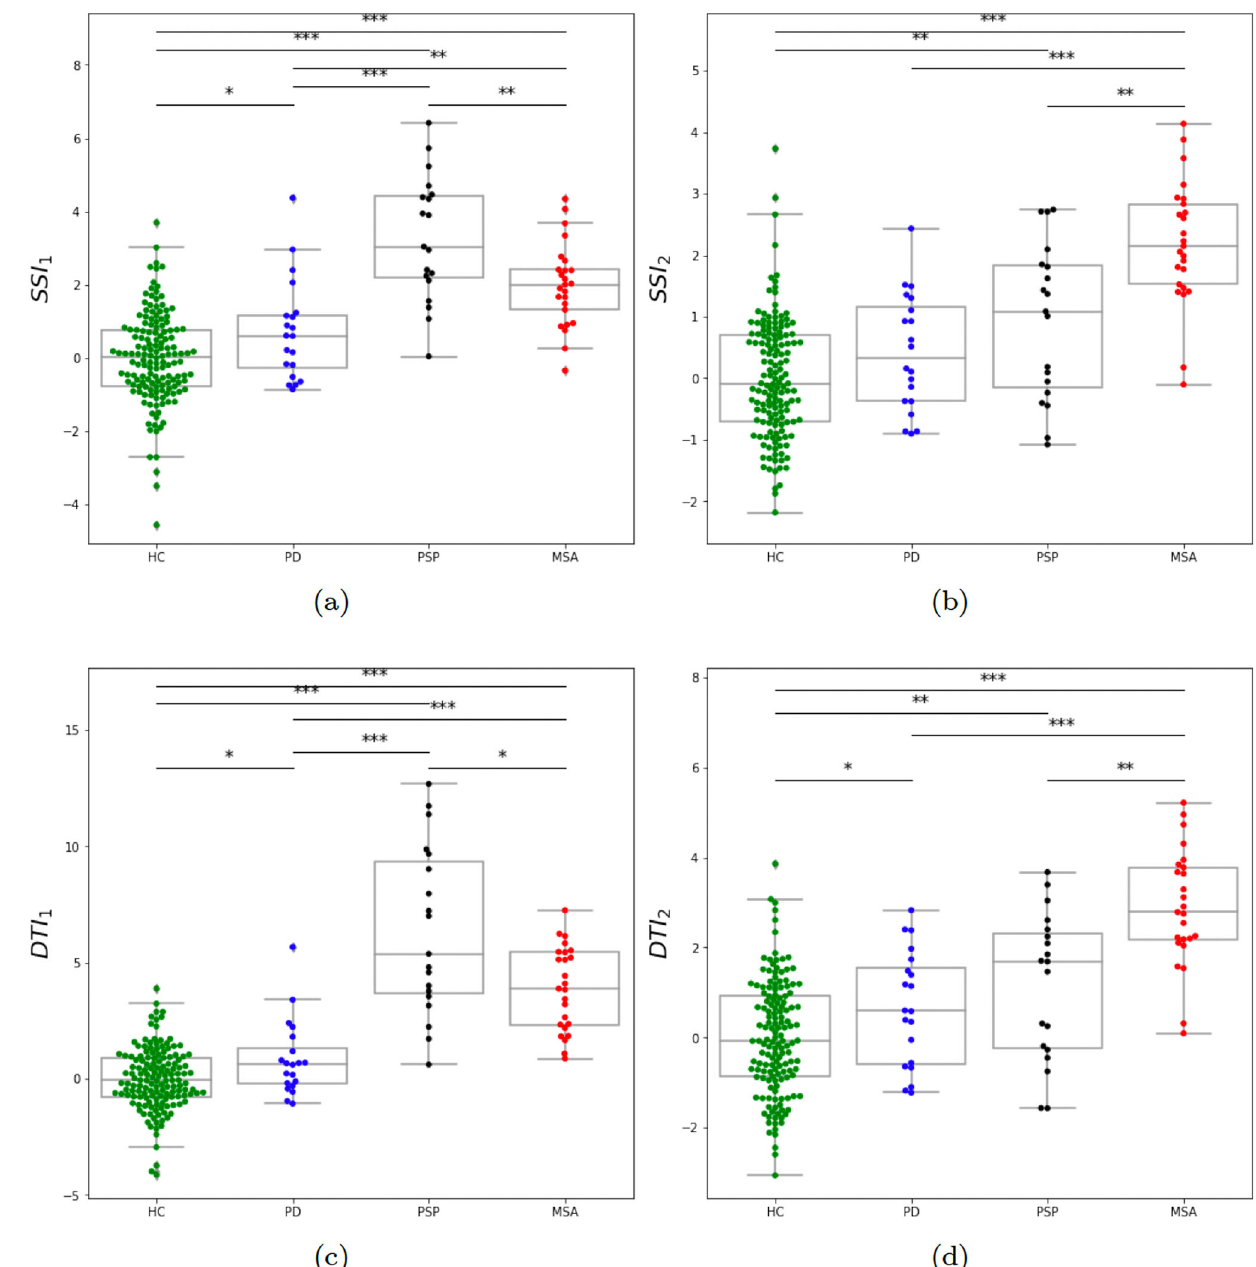
Fig. 3 Boxpolts of the distribution across groups of subsystem and dysarthria type indices. a SSI 1 = fi rst subsystem index; b SSI 2 = second subsystem index; c DTI 1 = fi rst dysarthria type index; d DTI 2 = second dysarthria type index. HC healthy controls, PD Parkinson ’ s disease, MSA multiple system atrophy, PSP progressive supranuclear palsy. Statistically signi fi cant differences between groups: * p < 0.05, ** p < 0.01, *** p <